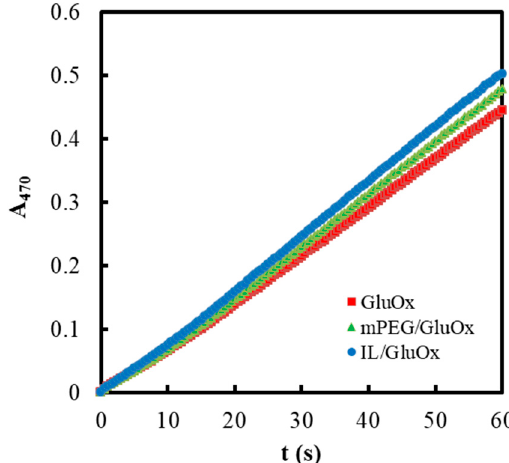
Figure 8. Initial reaction rates of GluOx (1.1 × 10 − 5 mM), mPEG/GluOx (2.67 × 10 − 3 mg/mL and 1.1 × 10 − 5 mM) and IL/GluOx (0.16% in final volume and 1.1 × 10 − 5 mM) in PBS (50 mM, pH 7.0, 25 °C) containing HRP (2.5 × 10 − 5 mM), guaiacol (3 mM), and D-glucose (50 mM).